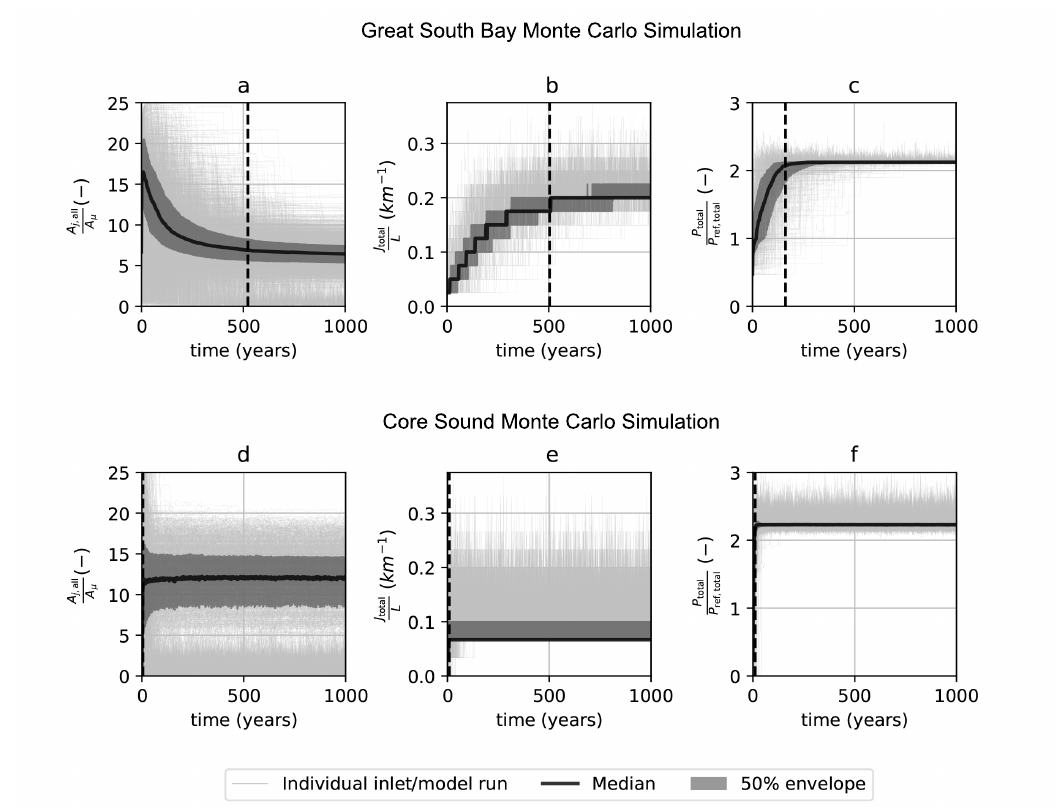
Figure 5. Results of two Monte Carlo simulations ( N = 500) for both the Great South Bay (top) and Core Sound (bottom). Shown are: the ratio A j ,all / A µ ( a , d ); the number of open inlets per km barrier coast J total / L ( b , e ); dimensionless total tidal prism P total / P ref,total ( c , f ), see Section 2.3. As these metrics are aggregated over all model runs, we show the mean (solid black), 50% envelope (dark grey), and individual model runs in light grey. The timescale to reach 90% of the final value has been indicated by dashed